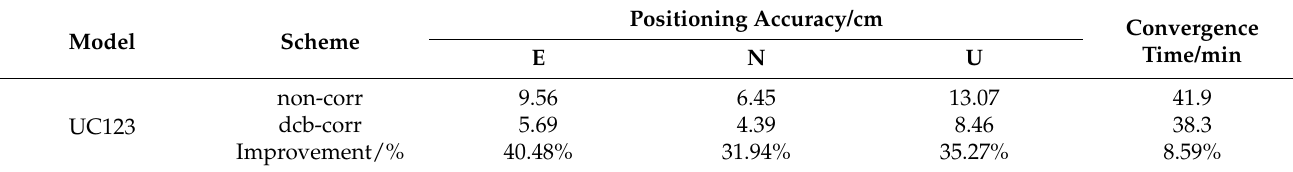
Table 7. Average positioning accuracy of PPP for UC123